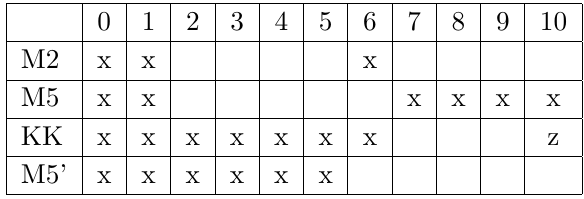
Table 2 . 1 -BPS brane intersection underlying the AdS 3 (cid:2) S 3 = Z k solutions in M-theory. The 8 directions ( x 0 ; x 1 ) are those where the 2d dual CFT lives, ( x 2 ; : : : ; x 5 ) span the CY 2 , x 6 is the ‘(cid:12)eld space’ direction and ( x 7 ; x 8 ; x 9 ) are the transverse directions on which the SO(3) R symmetry is realised. Finally, x 10 is the extra eleventh direction, which spans the S 1 = Z k (cid:26) S 3 = Z k and